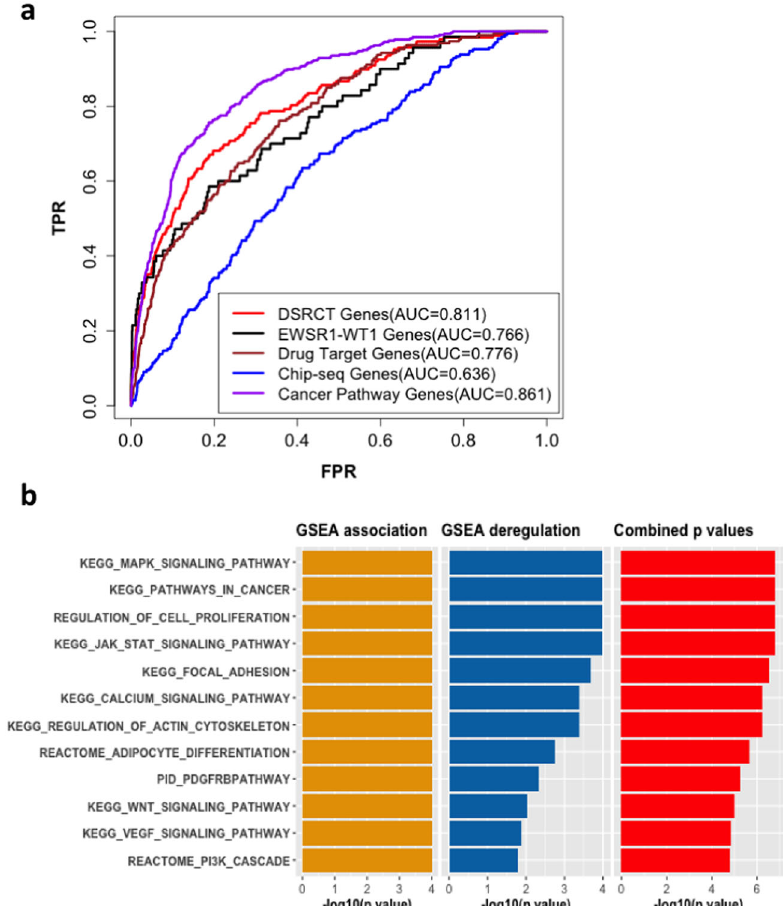
Fig. 6 Prediction of genes and pathways associated with EWSR1-WT1. a Prediction evaluation using four benchmark gene sets: 74 genes cited with EWSR1-WT1 in the literature (denoted EWSR1-WT1 genes), 201 genes cited with DSRCT in the literature (denoted DSRCT genes), 194 target genes of compounds that have been tested in clinical trials or used for the treatment of DSRCT (denoted drug targets), 268 genes whose promoter regions were peak binding sites of WT1 by ChIP-Seq (indicated as ChIP-Seq genes), and 328 genes categorized in the KEGG cancer pathways (denoted cancer pathway genes). Genes in these four gene sets were treated as positive instances, and the remaining genes were treated as negative instances. TPR indicates true positive rate; FPR, false positive rate; and AUC, area under the ROC curve. b Bar plot of some statistically signi fi cant pathways that are associated with EWSR1-WT1 in our prediction. Each bar represents the statistical signi fi cance of a given pathway in GSEA association analysis (pathway analysis of the network association), GSEA deregulation analysis (pathway analysis of gene expression deregulation), or combination analysis. The statistical signi fi cances are presented in the graph as -log10 ( p prediction, to identify pathways associated with the EWSR1-WT1 fusion in the gene network (termed GSEA association analysis). Since the gene network used in the prediction contains molecular interactions across different cell types, not all predicted associated pathways (GSEA association analysis) are deregulated by EWSR1-WT1 in DSRCT 37 . Therefore, we also applied GSEA to determine the deregulation level of each associated pathway in the network prediction using the differential gene expression data between DSRCT and the adjacent omentum samples (termed GSEA deregulation analysis). We then used the truncated product method [59] to combine the p -values of the GSEA association analysis mentioned above with the GSEA deregulation analysis for each pathway to identify pathways that were not only highly associated with the EWSR1-WT1 fusion in the network analysis but also signi fi cantly deregulated in DSRCT (Fig. 6b, Supplementary